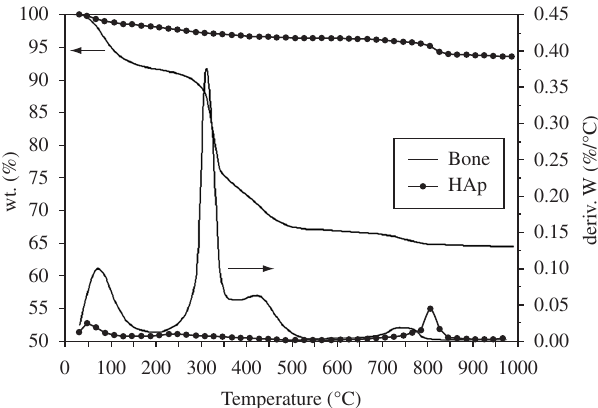
Figure 2. Thermogravimetric curves of bone and HAp